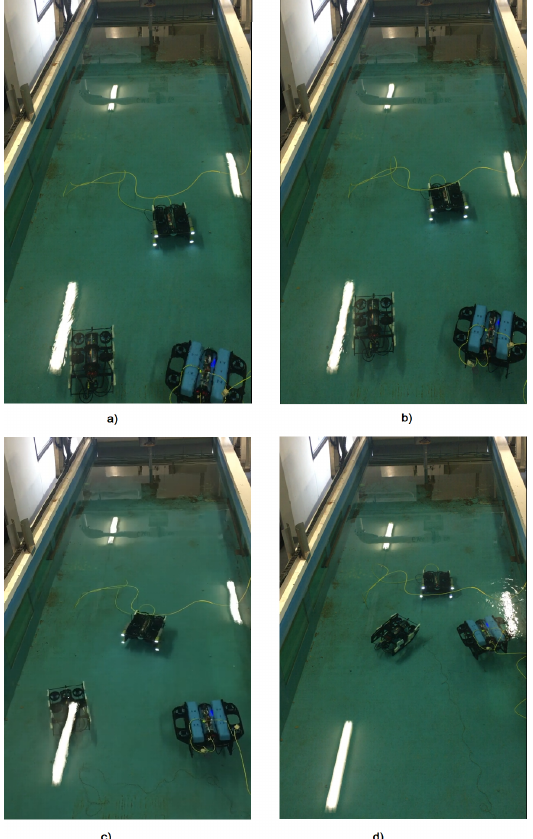
Figure 11. Testing of three robots forming a formation and moving according to the leading robot. ( a ) description of the initial positions of the robots. ( b , c ) illustration of robot group movement. ( d ) indicating the formation of the